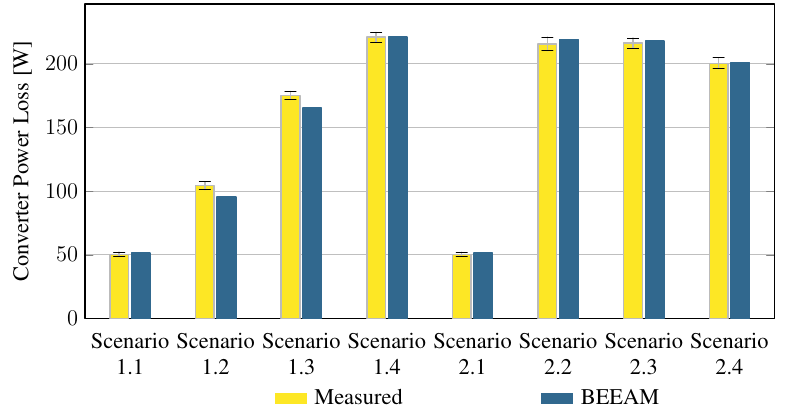
Figure A17. Predicted versus measured converter loss, Scenarios 1 and